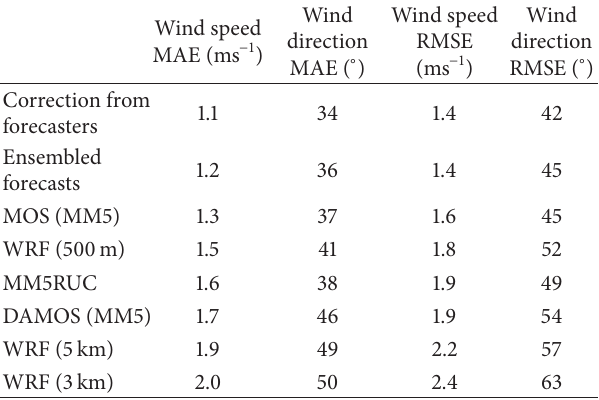
Table 2: Statistical analyses for four buoy stations during the period of August 9–21,